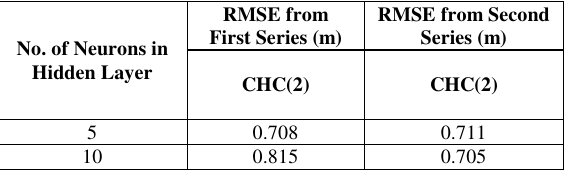
Table 9: Results of Interpolation using ANN